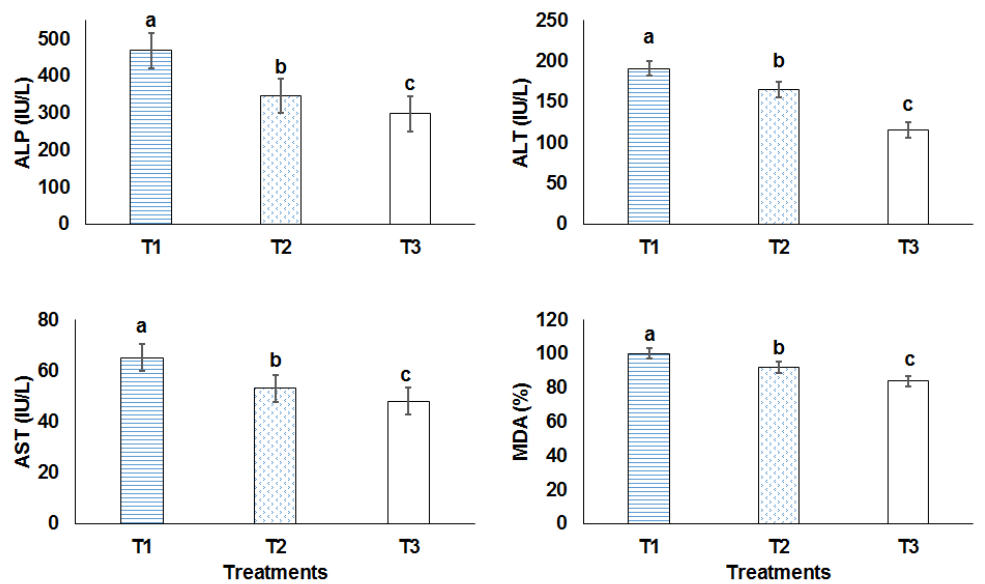
Figure 2. Enzymes and lipid peroxidation changes in liver. T1: induced colorectal cancer; T2: induced colorectal cancer received 100 mg/kg/day phenolics; T3: induced colorectal cancer received 100 mg/kg/day nanoliposome-loaded phenolics. Different letters indicated significant difference ( p <